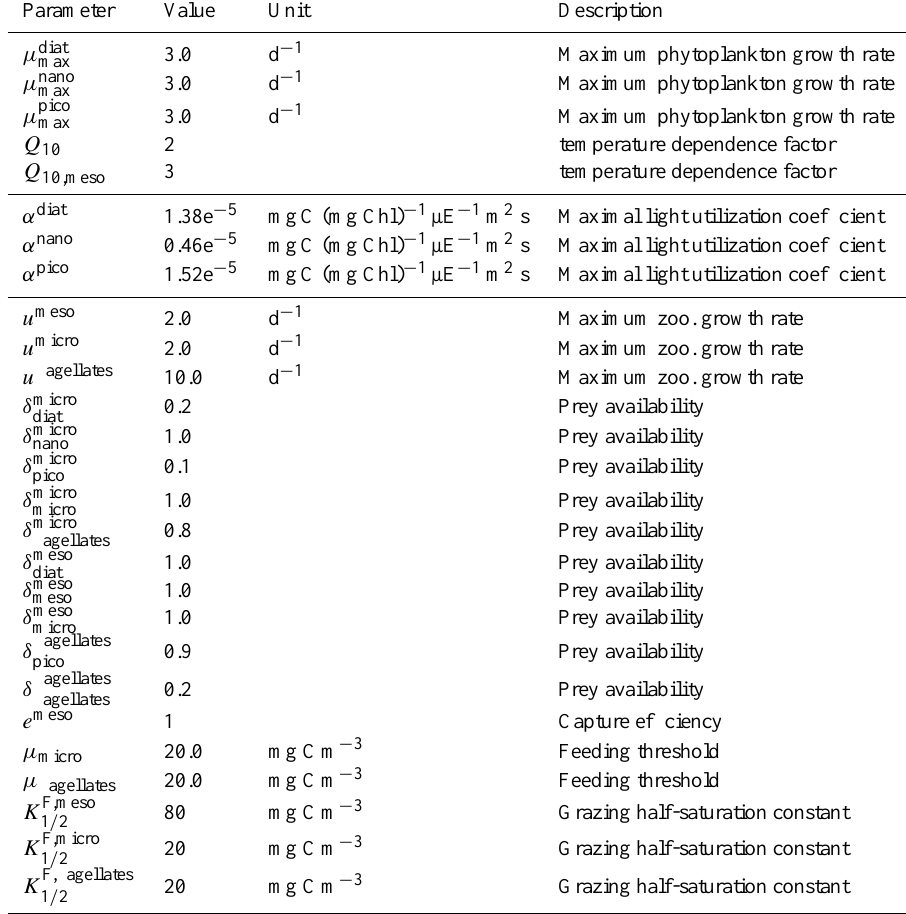
Table A6. PELAGOS